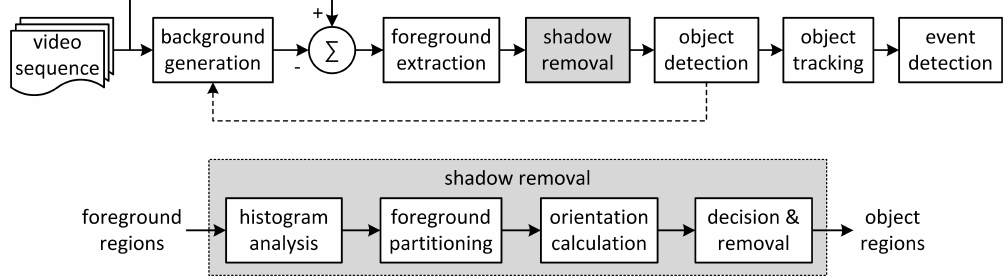
Figure 4. Video content analytics with the proposed shadow detection algorithm for nighttime video